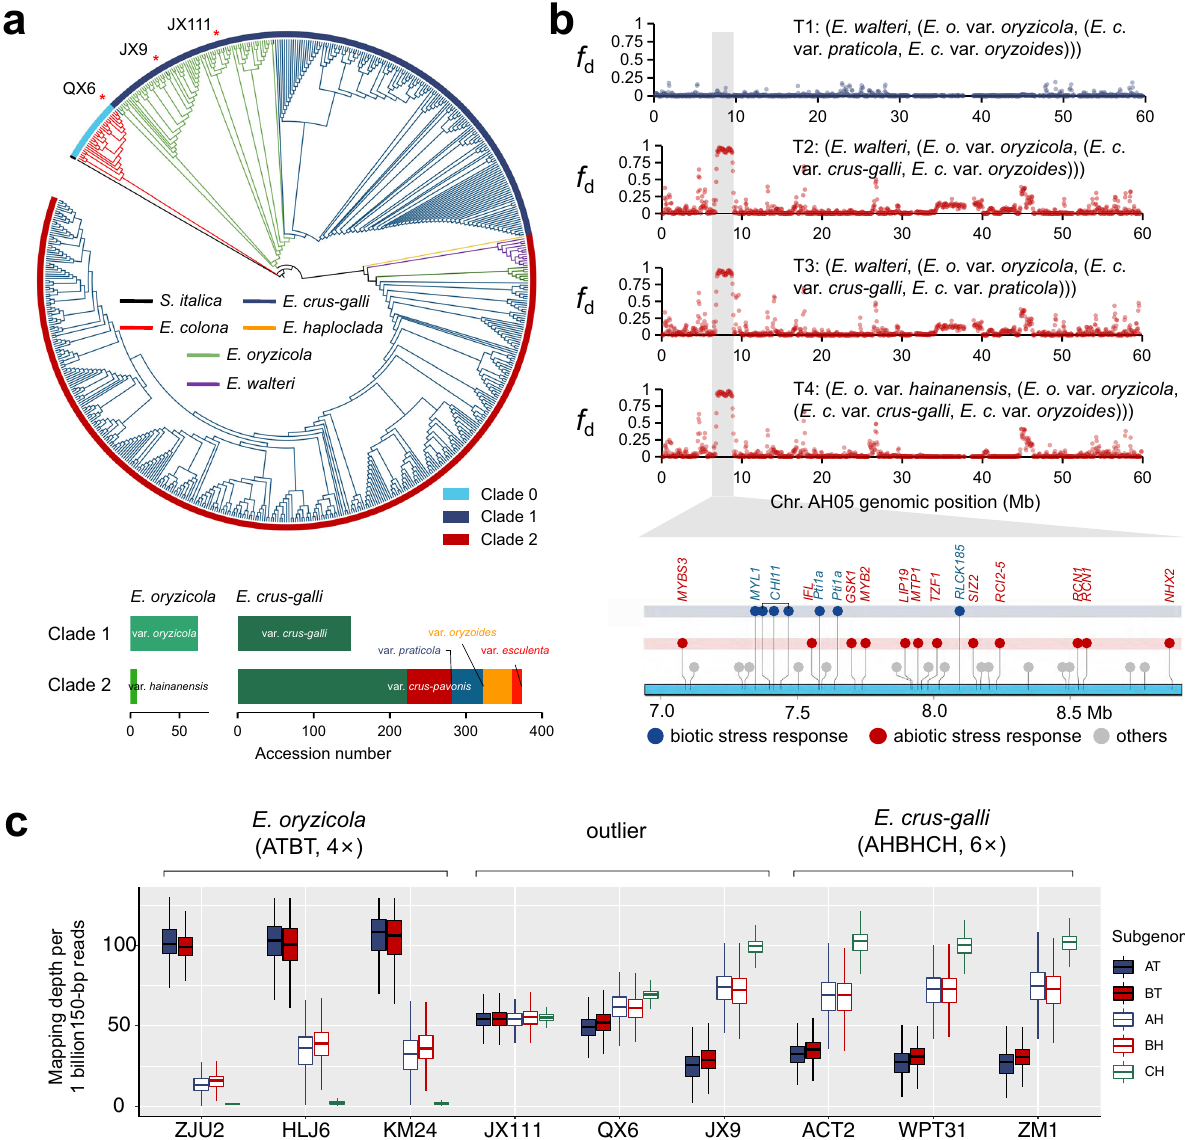
Fig. 3 Sympatric gene fl ow among Echinochloa species. a A maximum-likelihood phylogeny based on single nucleotide polymorphisms (SNPs) in the chloroplast genomes of Echinochloa accessions ( n = 607). Three non- E. oryzicola accessions (QX6, JX111, and JX9) clustered within E. oryzicola var. o ryzicola (clade 1) are indicated by red asterisks. Histogram charts below the phylogeny tree show the species and variety compositions in clade 1 and clade 2. b Proportion of introgression f d distributions of ABBA-BABA test on chromosome AH05 in topology T1 – T4 (see details in Supplementary Fig. 28). Stress- responsive genes with sequences ranging from 7 Mb to 9 Mb on chromosome AH05 are shown in the lower panel. c Mapping depths when reads from three E. oryzicola accessions, three E. crus-galli accessions, and three outliers are mapped against the pseudo-decaploid reference genome (STB08 + ZJU2). In the box plots, the horizontal line shows the median value, and the whiskers show the 25% and 75% quartile values of mapping depths of 1-Mb sliding windows in fi ve subgenomes (window number: n = 506 AT, n = 421 BT, n = 478 AH, n = 405 BH, n = 421